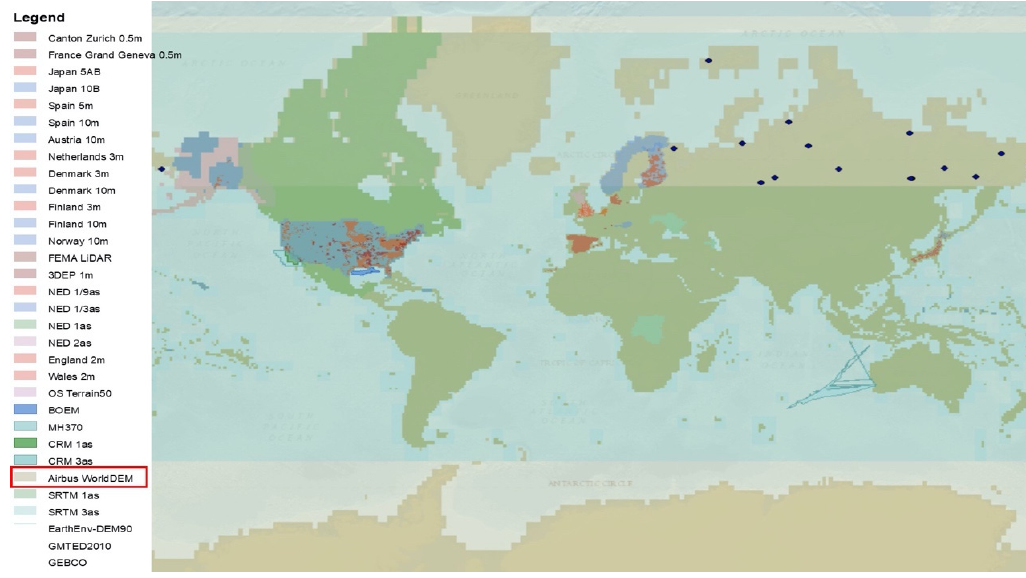
Figure 5. Subset of Esri elevation sources included in “Terrain” layer [44].